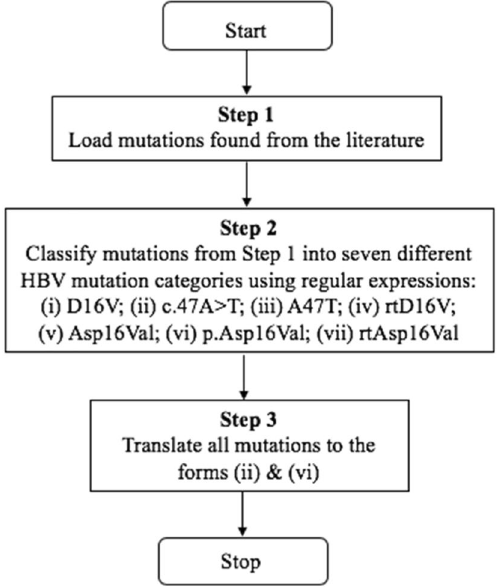
Figure 2. Normalization of DNA and amino acid mutations found from text mining the literature, to enable the direct comparison with clinical study mutations.